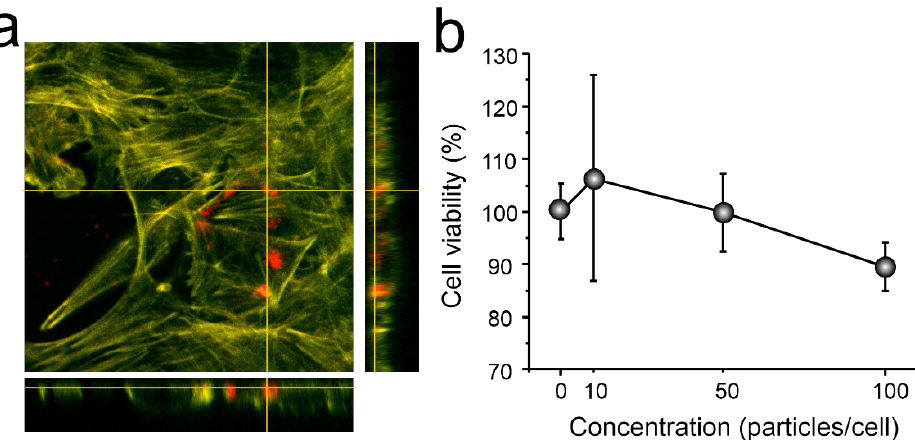
Figure 8. ( a ) CLSM orthogonal projection of carriers inside 4T1 cells after 24 h joint incubation (Red is fluorescence due TRITC in particles); ( b ) cytotoxicity (WST-1) of carriers for 4T1 cells after 24 h join incubation.